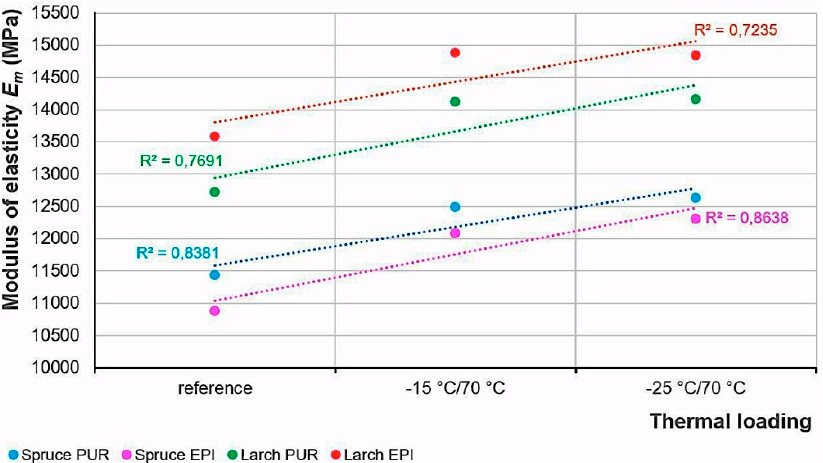
Figure 9. Correlation between modulus of elasticity and thermal loading.